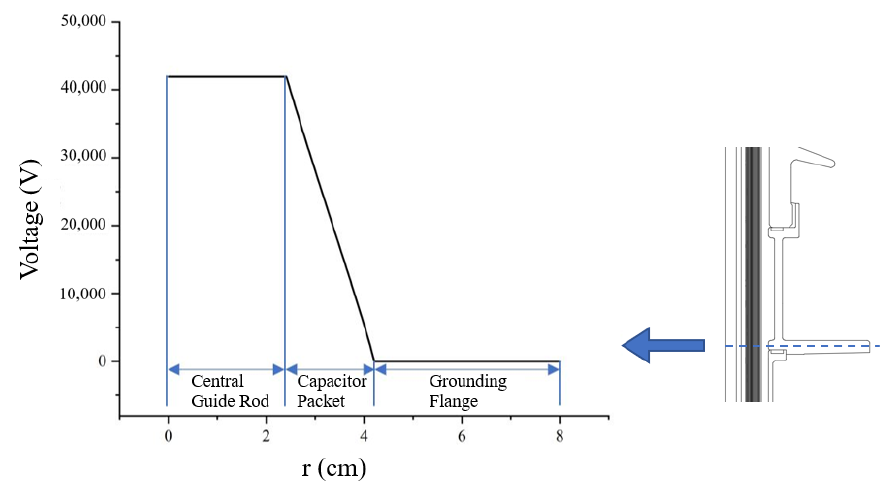
Figure 11. Voltage distribution of the transformer bushing.